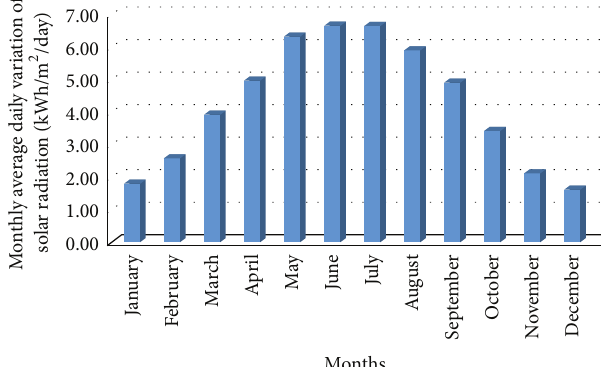
Figure 8: Monthly average daily variation of solar radiation over the year.